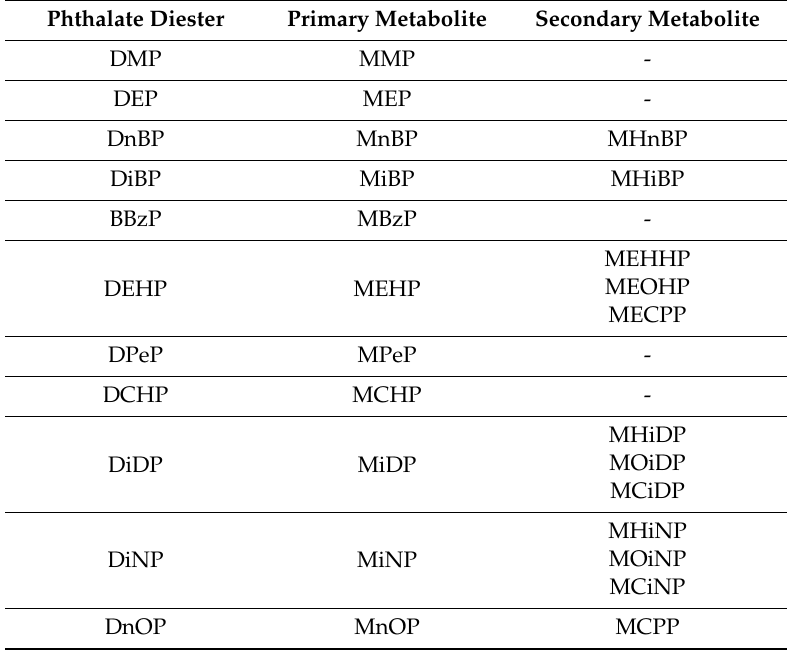
Table 2. Primary and secondary metabolites of the selected diesters of phthalates [66]. Phthalate